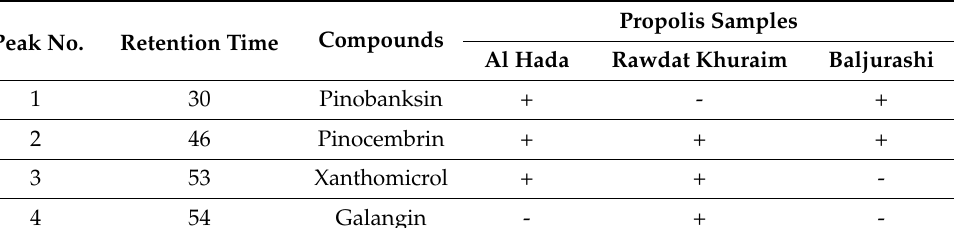
Table 2. The HPLC analysis showing the active compounds of the propolis extract from three isolation sites in Saudi Arabia. Peak No.